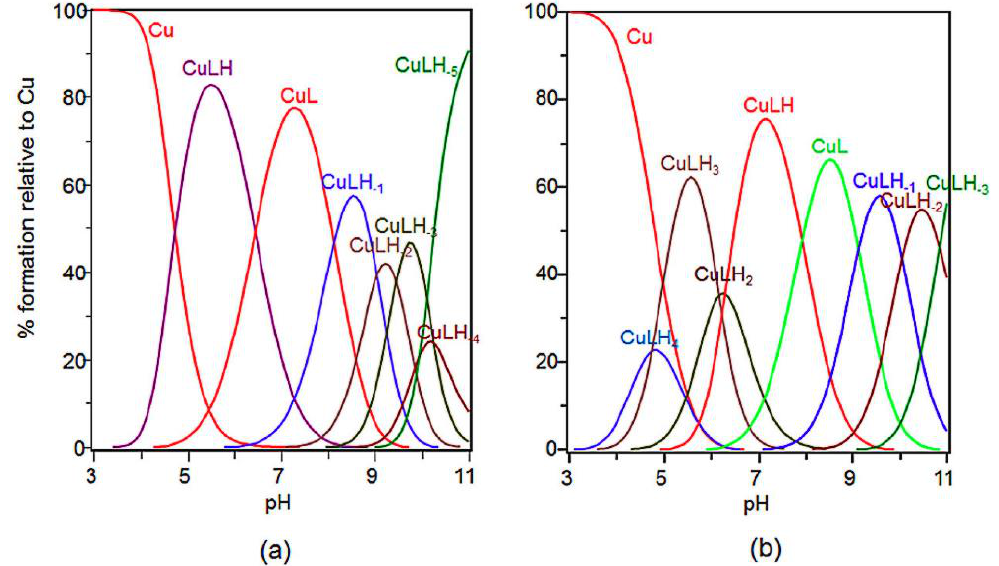
Figure 1. Species distribution of copper(II) complexes with: ( a ) Ang1-17; and ( b ) AcAng1-17. [L] = 1 × 10 −3 M; metal-to-ligand molar ratio of 1:1. From Ref. [45], under Attribution 4.0 International, CC BY 4.0.